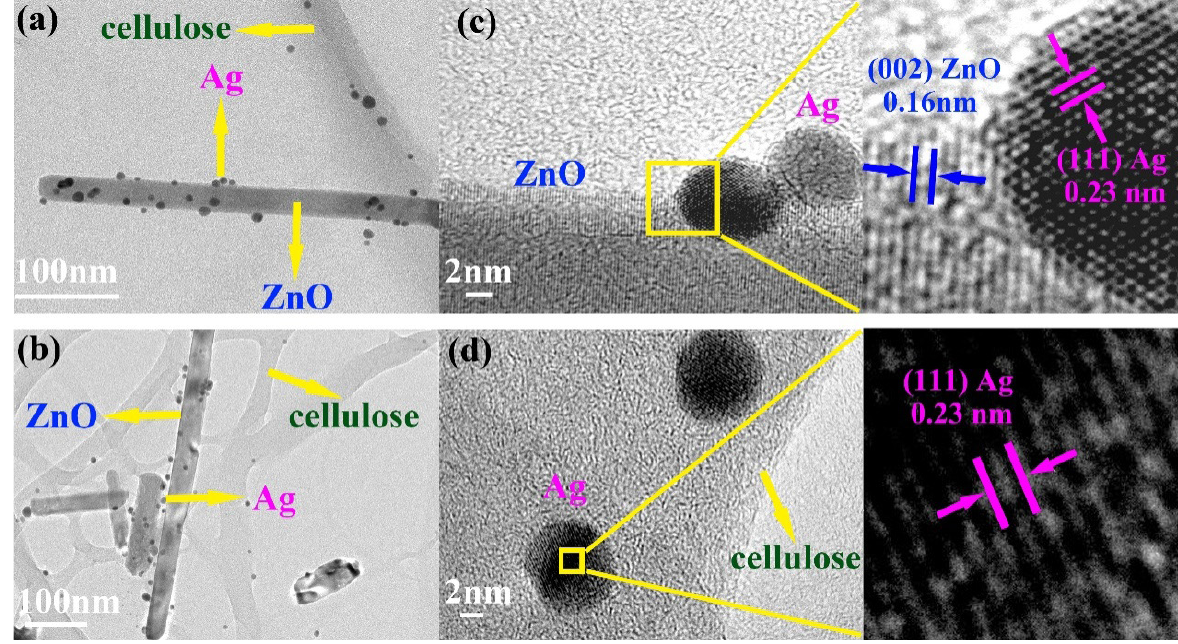
Figure 3: TEM images of ZAC-12 (a and b), and high-resolution transmission electron microscopy (HRTEM) images (c and d).